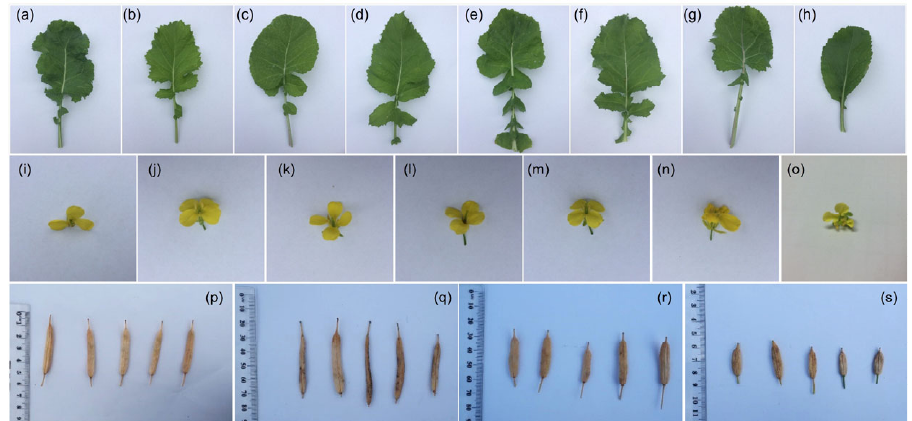
Figure 2. Morphological variation of leaves, flowers and pods in S 2 generation derived from an allohexaploid Brassica hybrid H16-1 DH population. ( a ) Thick, curled and deep-colored leaves. ( b ) Thin leaves with light color. ( c ) Round leaves. ( d ) Two pairs of stipules. ( e ) Four pairs of stipules. ( f ) Curl leaves. ( g ) Purple petioles. ( h ) Oval leaves. ( i ) Flower with three petals. ( j ) Normal flowers. ( k ) Over-opened petals. ( l ) Anthers shorter than stigma. ( m ) Petals with similar length and width. ( n ) Crinkled petals. ( o ) Abnormal flowers. ( p ) Plump pods with long siliques, long pedicels and medium beaks. ( q ) Shriveled pods with long siliques, short pedicels and long beaks. ( r ) Average pods with medium siliques, long pedicels, and medium beaks. ( s ) Empty pods with short siliques, medium pedicels and short beaks.